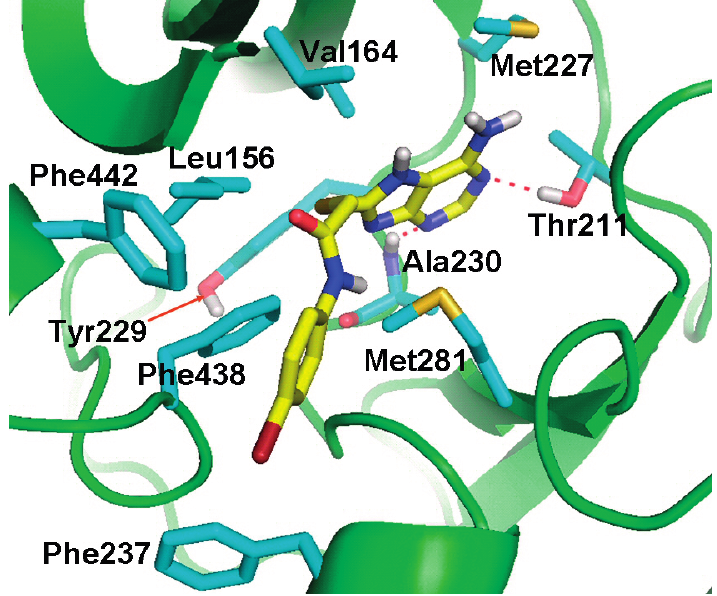
Figure 8. Docking model of Compound a48 fit into the ATP-binding site of Akt kinase. Compound a48 (yellow) and some representative amino acid residues (cyan) interacting with Compound a48 are shown as stick structures. The red dashed lines indicate hydrogen-bonding